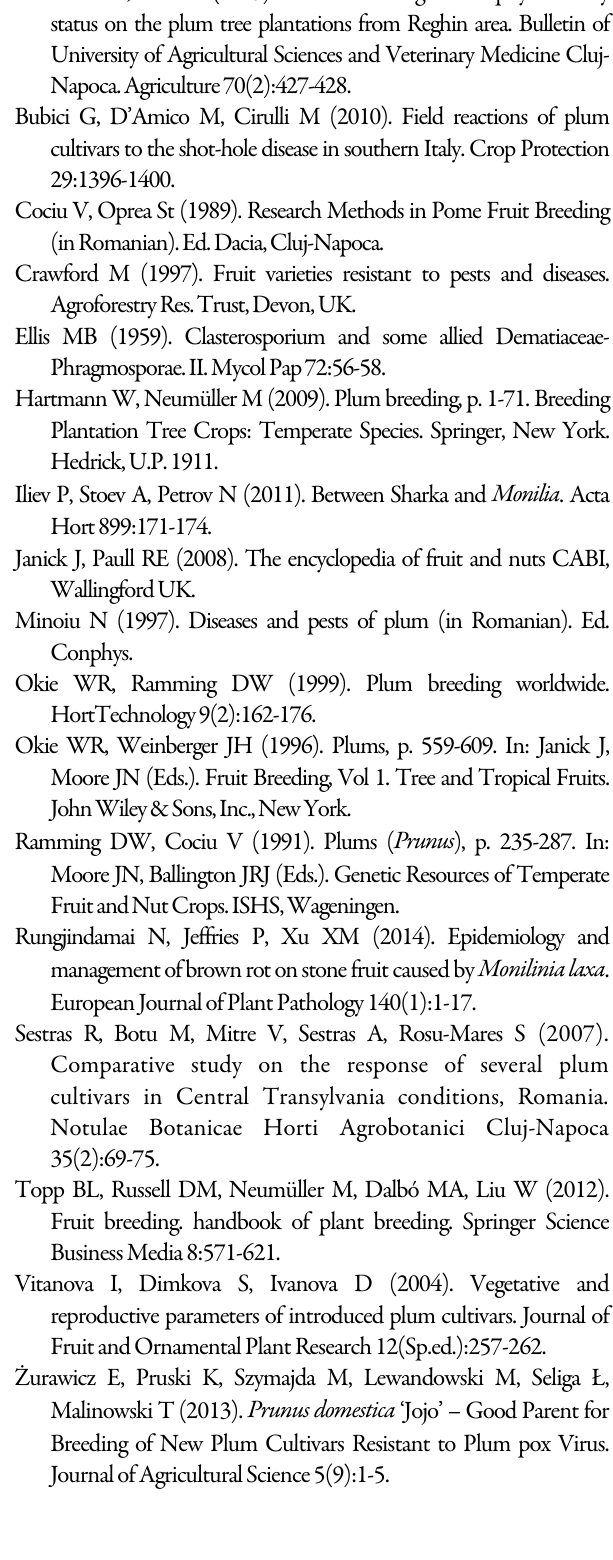
Table 2. The response of plum cultivars to red staining of plum ( Polystigma rubrum ) and shot-hole ( Stigmina carpophila ) attack on the leaves, under natural infection